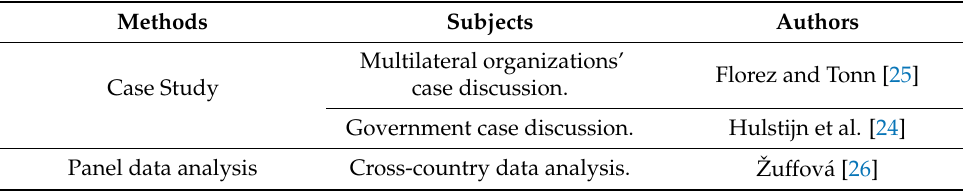
Table 2. Study on open government data and